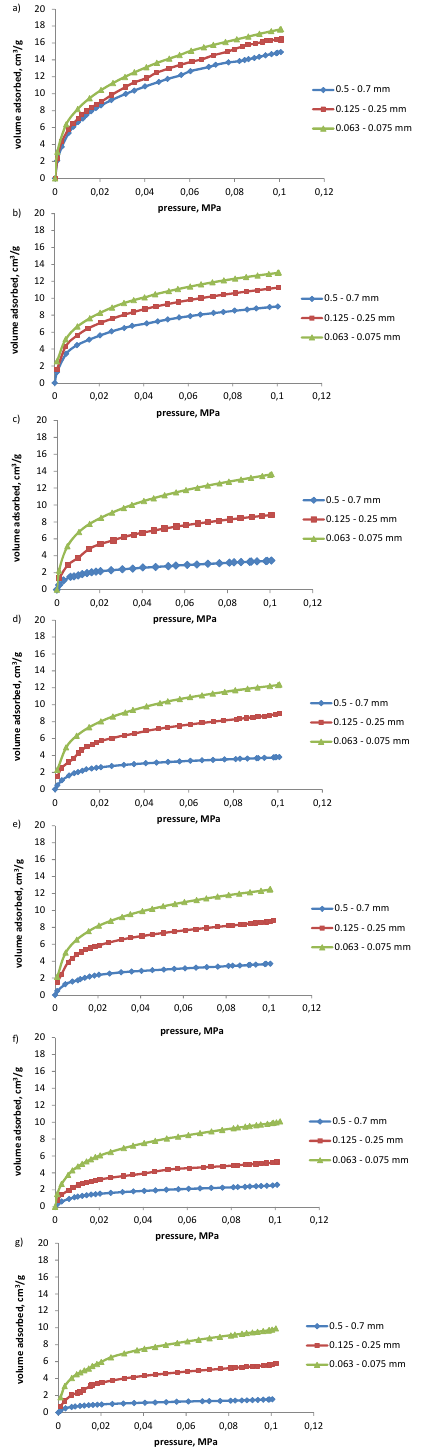
Figure 1. Isotherms of propylene sorption at 298 K on coal samples ( a ) no. 1, ( b ) no. 2, ( c ) no. 3, ( d ) no. 4, ( e ) no. 5, ( f ) no. 6, and ( g ) no. 7.